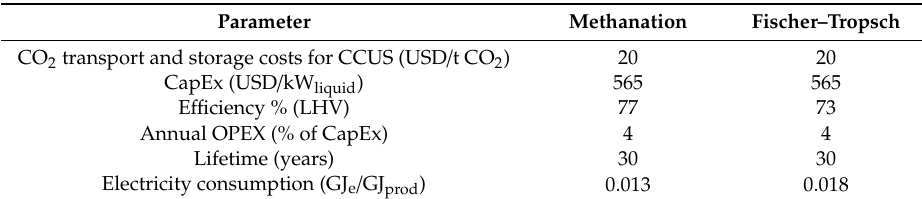
Table 1. Cost estimation parameters for synthetic fuel and Methane production in the long term [25].